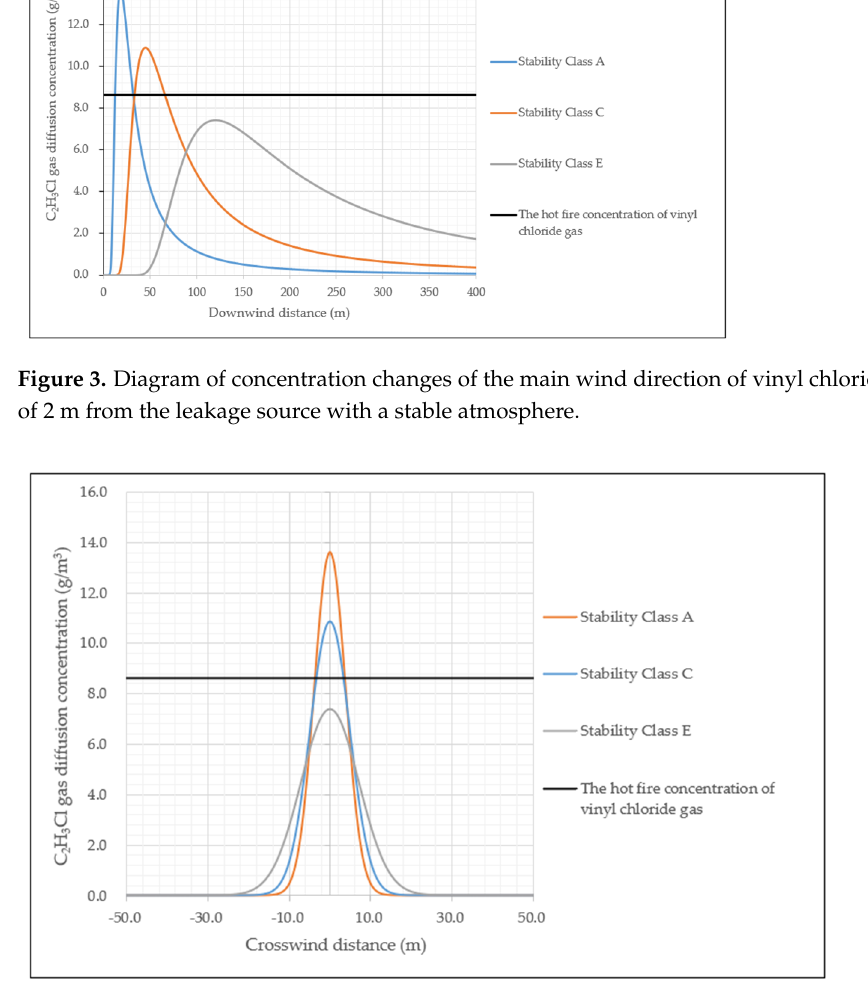
Figure 4. Concentration changes in crosswind direction of vinyl chloride under different atmos- pheric stabilities.